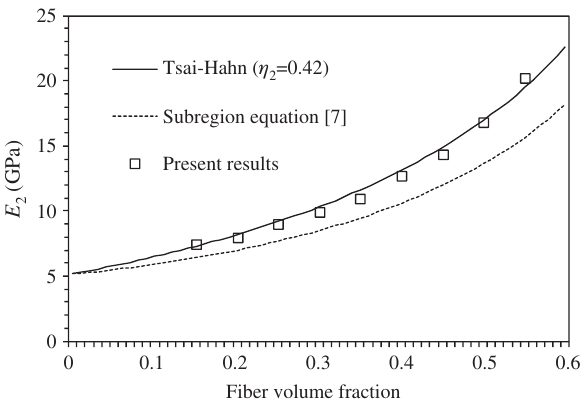
Figure 6 Transverse modulus for boron/epoxy.